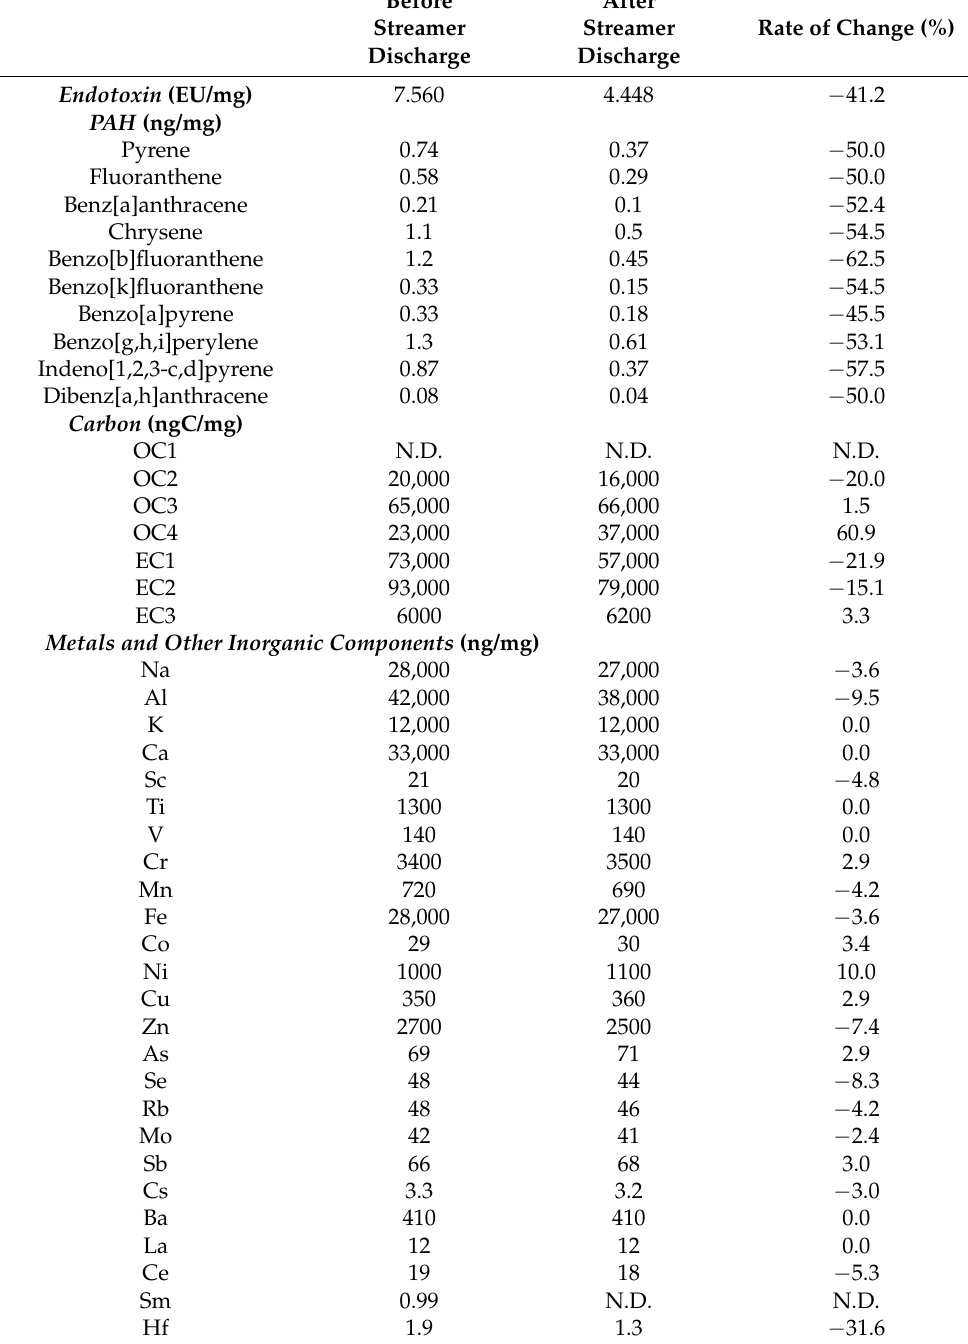
Table 1. Composition analysis of PM2.5 collected from Bangkok (Sep.–Dec.) before and after